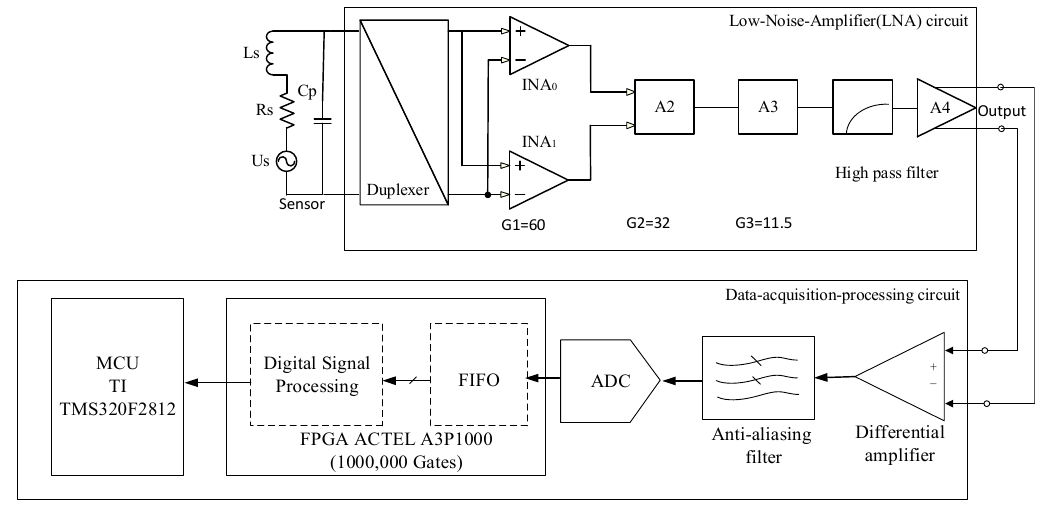
Figure 1. Structures of the lock-in amplifier circuit, the acquisition circuit, and the processing circuit.